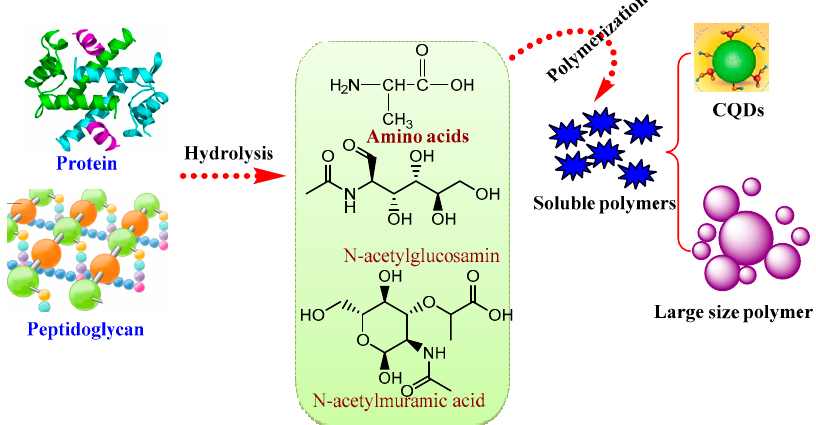
Figure 7. Cyanobacteria-derived CQDs possible preparation.